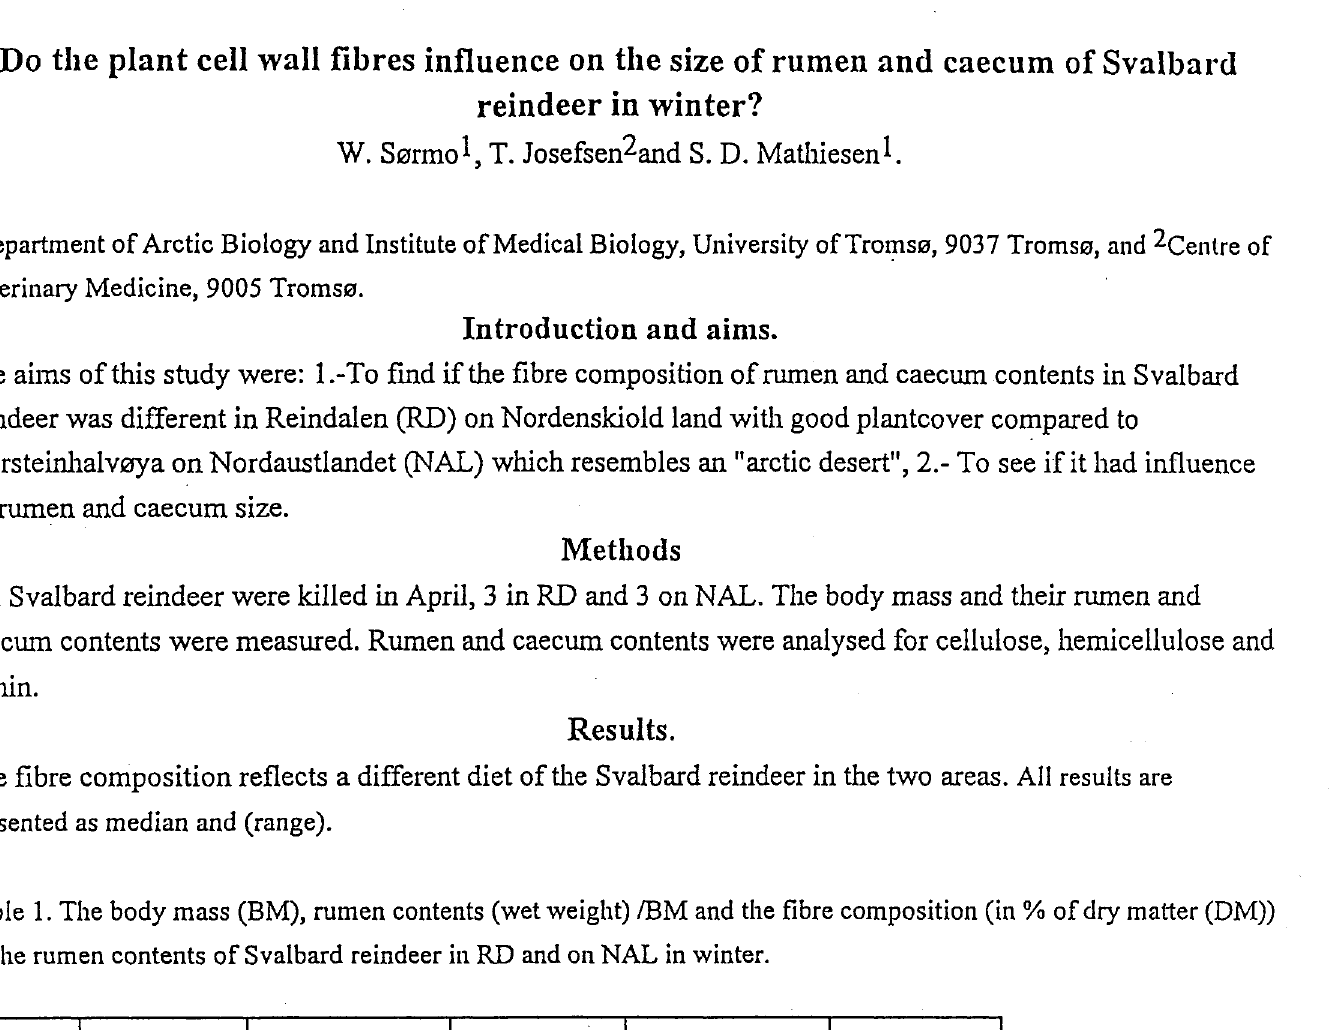
Table 2.Caecum contents (wet weight) /BM and the fibre composition (in % of dry matter (DM)) of the caecum contents of Svalbard reindeer in RD and on NAL in